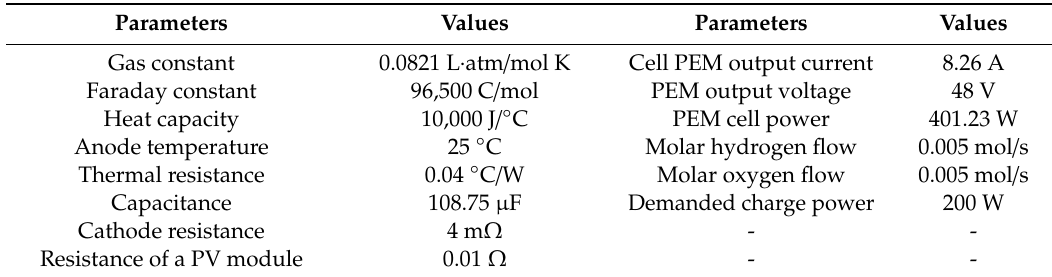
Table 3. Steady-state values for the fuel cell.